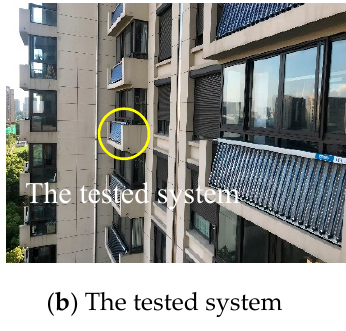
Figure 12. Photos after completing the installation.